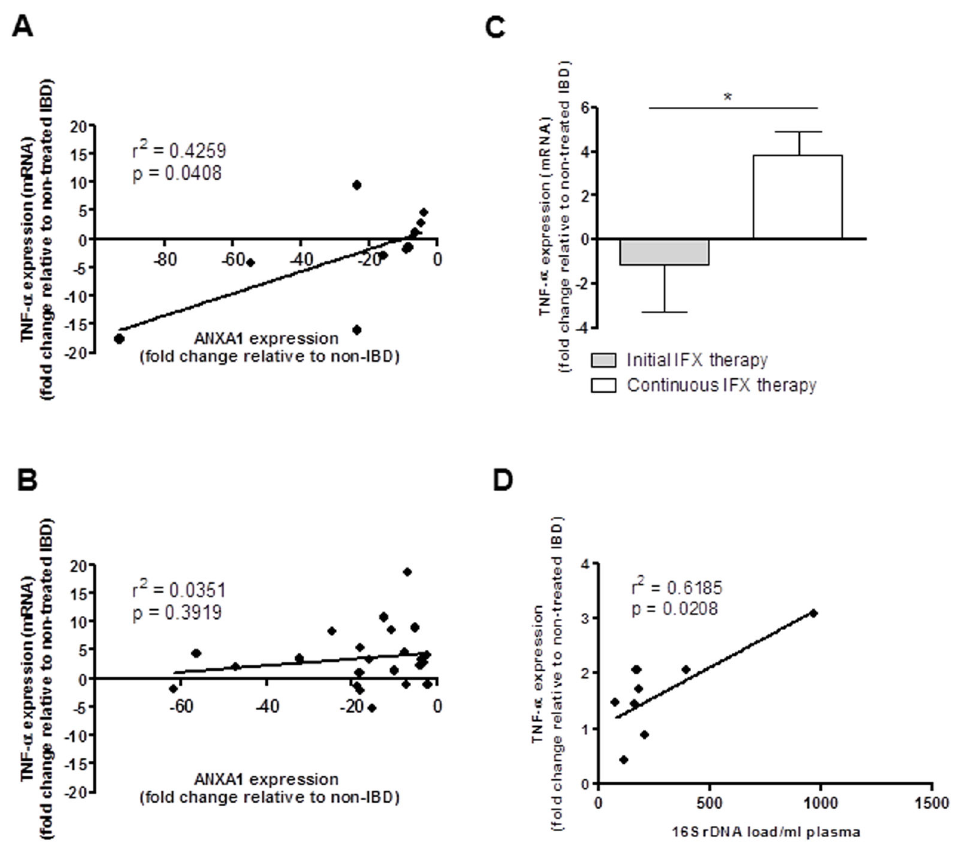
Figure 4. Correlation of TNF-α vs ANXA1 transcripts demonstrated an increase transcription of TNF-α following IFX therapy, also associated with plasma bacterial 16S load. The linear regression graphs (A) and (B) showed the relation between ANXA1 and TNF-α expression in the PBMC from patients prior to (A) and following IFX therapy (B), in IBD patients relative to IBD patients not initiating IFX therapy. (C) PBMC of IBD patients showed that following continuous IFX treatment there were higher transcriptional levels of TNF-α, compared to short term therapy, which could be due to compensatory mechanisms following ongoing TNF-α blocking therapy. (D) There was a significant positive correlation between TNF-α expression and increased bacterial load in patients with IBD (16S rDNA).